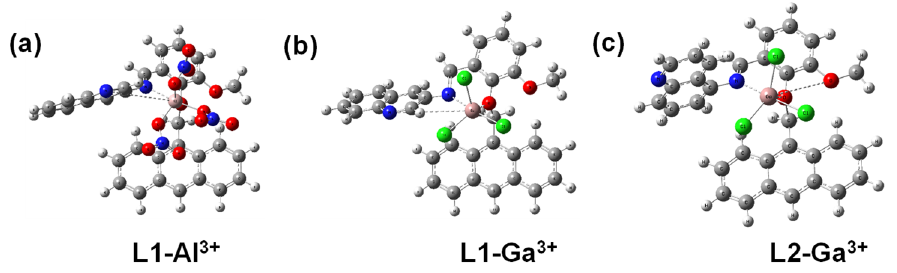
Figure 11 . Optimized structures of L1 -Al 3+ , L1 –Ga 3+ , and L2 –Ga 3+ complexes (Isovalue = 0.02). The associated anions (NO 3 and Cl ) are shown in their usual colors.